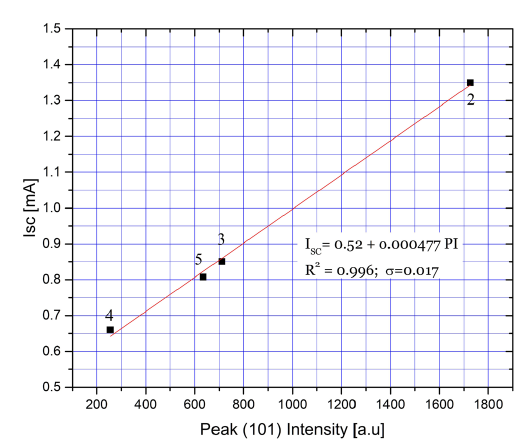
Figure 10. Ti 2p3/2 shake-up satellite surface dependence on BL and the SC polarization. Inset; TiO